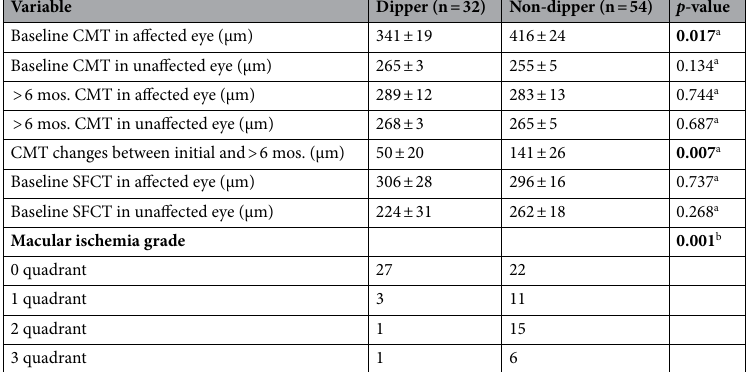
Table 2. Comparison of central macular thickness, choroidal thickness, and macular ischemia between the dipper and non-dipper groups of patients diagnosed with branch retinal vein occlusion. Data are presented as mean ± standard deviation. Night to day systolic blood pressure ratio (%) = (Daytime sysBP − Nighttime sysBP)/Daytime sysBP × 100. Dipper ≥ 10%; Non-dipper < 10%. Statistically significant values appear in boldface. CMT central macular thickness, mos. months, SFCT subfoveal choroidal thickness. a Based-on Student’s t-test. b Based-on Chi-square.